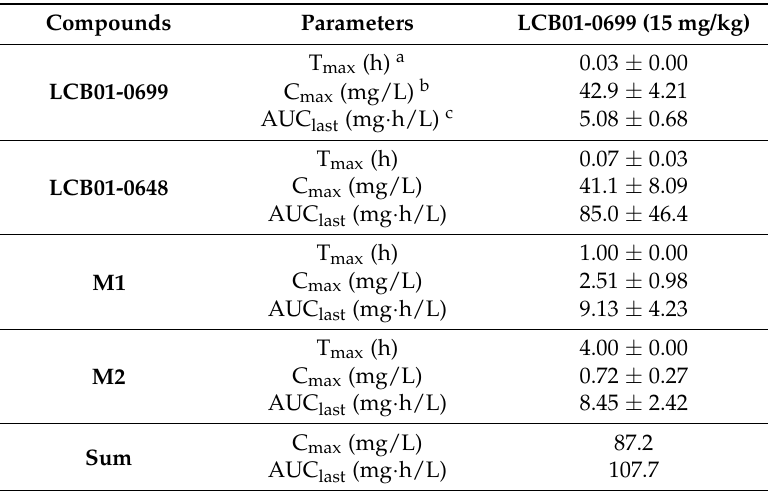
Table 1. Pharmacokinetic parameters of LCB01-0699 and metabolites in rat plasma after a single 15 mg/kg intravenous (i.v.) injection of LCB01-0699 ( n = 3).